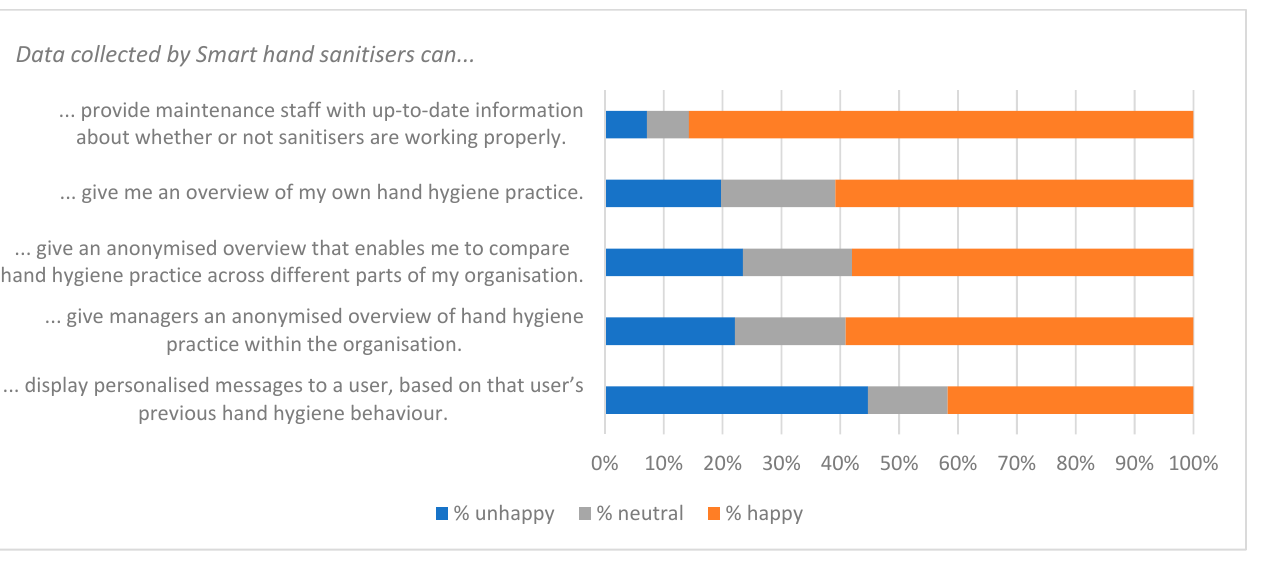
Figure 6. Acceptance of monitoring.